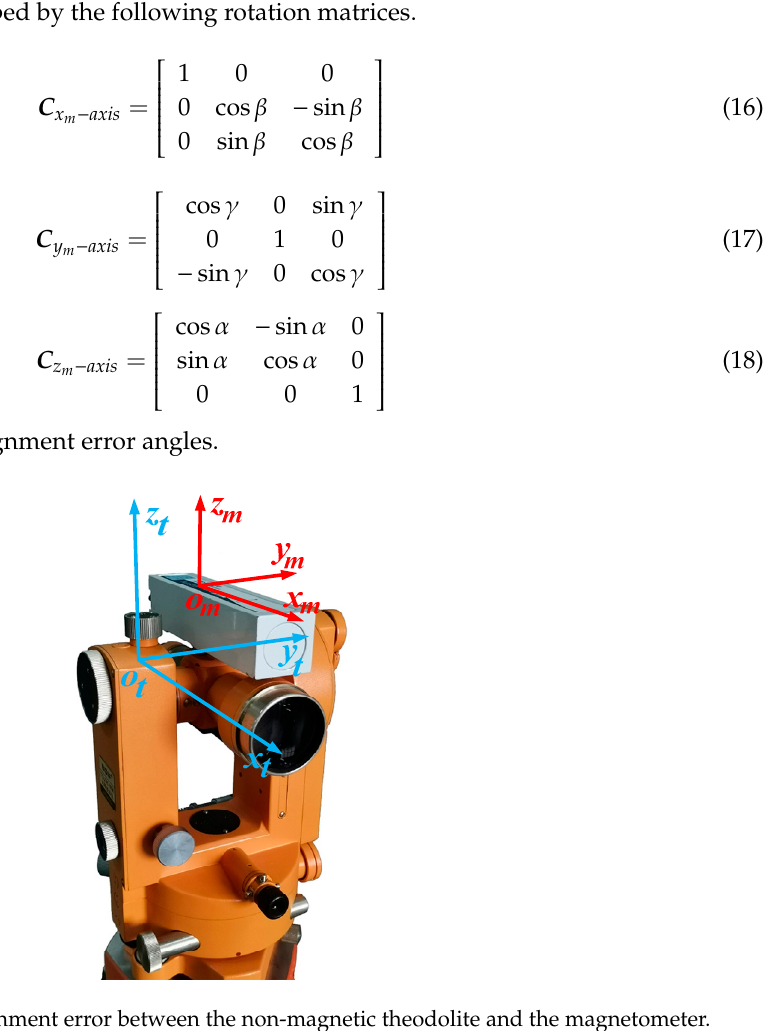
Figure 2. Diagram of misalignment error between the non-magnetic theodolite and the magnetometer.